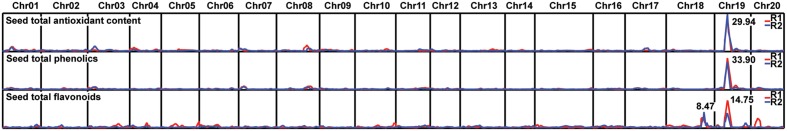
Log-of-odds (LOD) score distribution of quantitative trait loci (QTLs) across the 20 chromosomes. The maximum LOD score of each trait is indicated next to the peak. Red and blue lines represent the LOD scores of two biological repeats.